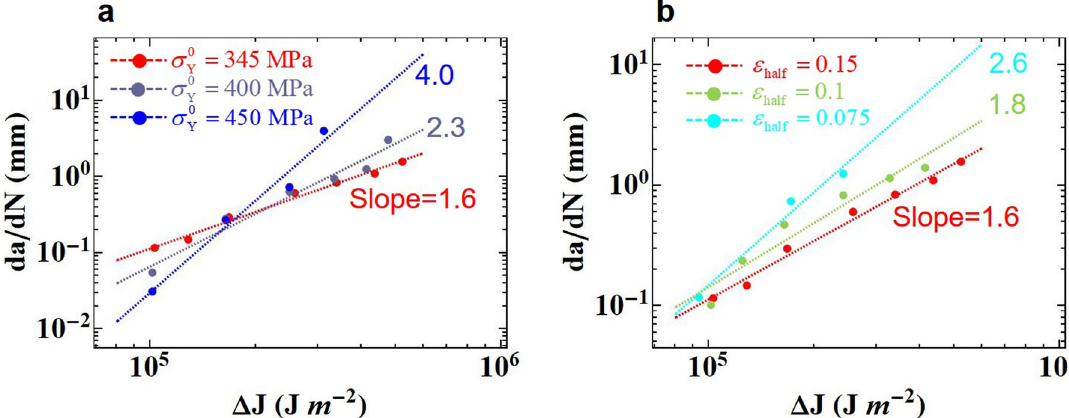
Fig. 9 Crack growth rate versus the path integral Δ J . a Results with different initial yield strength. b Results with different values of ε half . The dots with different colors represent the results from phase- fi eld simulations, and the dotted lines are fi tted based on the simulation results. The slopes of the fi tted lines are labeled.